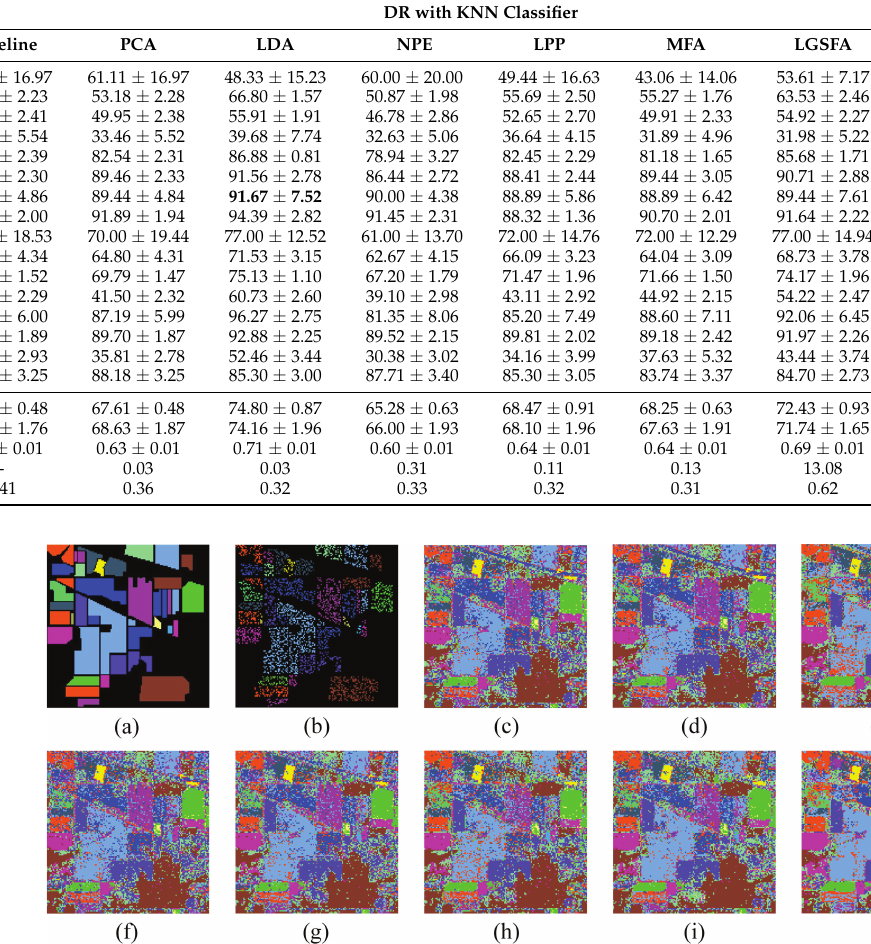
Figure 12. Classification results of different approaches for Indian pines dataset. ( a ) Ground truth; ( b ) Training samples; ( c ) Baseline; ( d ) PCA; ( e ) LDA; ( f ) NPE; ( g ) LPP; ( h ) MFA; ( i ) LGSFA; ( j )